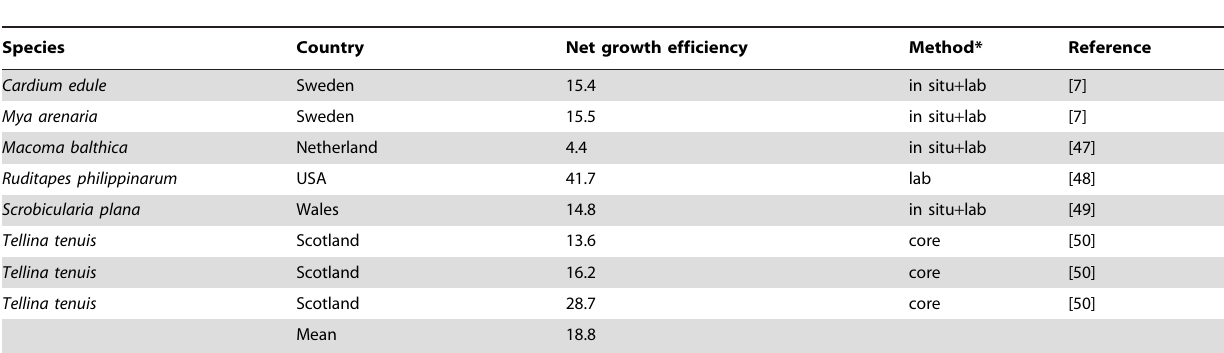
Table 1. Net growth efficiency (%) of